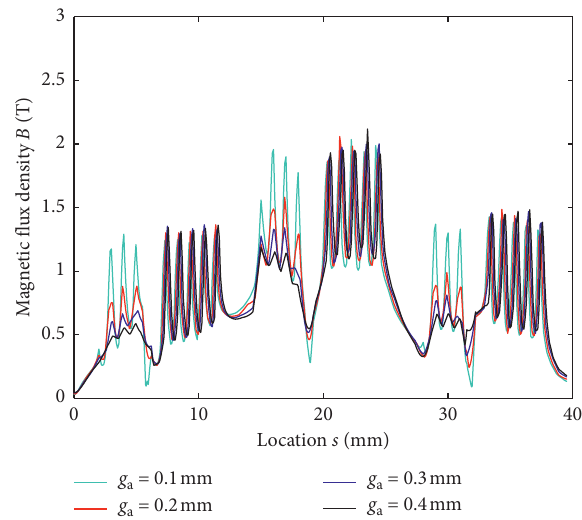
Figure 6: Magnetic field distribution with different axial sealing : axial sealing position position widths. g a